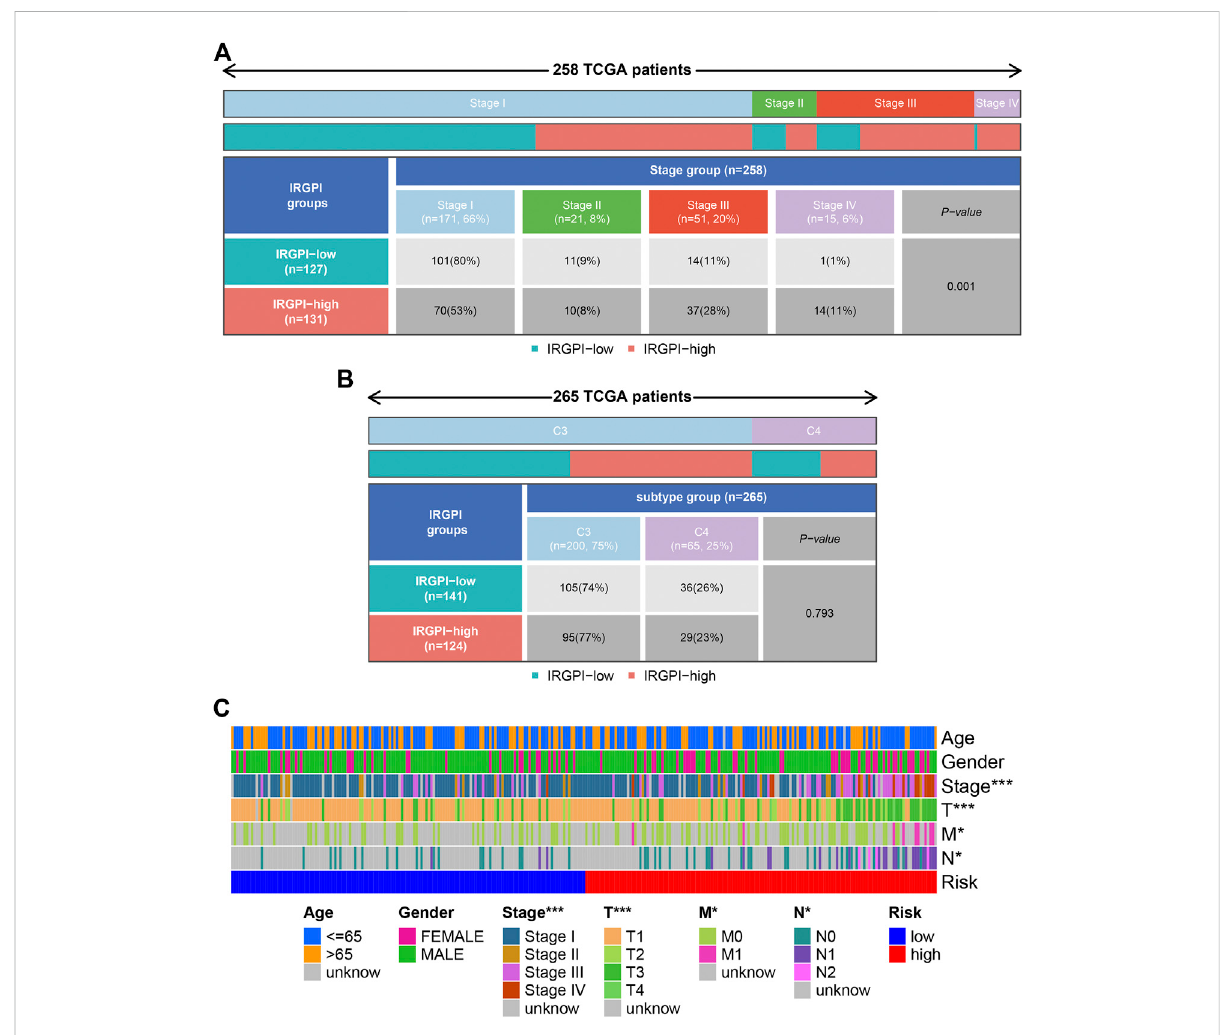
FIGURE 7 Clinical correlation analysis. Heatmap and table showing thedistribution of PRCC pathological stage (A) and immune subtypes (B) betweenthe IRGPI subgroups. (C) Cellular landscape of the relationship between the IRGPI and the different clinical features, including the age, gender, tumor stage, T stage, tumor N stage, and tumor M stage. *** p < 0.001, ** p < 0.01, * p < 0.05. IRGPI, immune-related gene prognostic